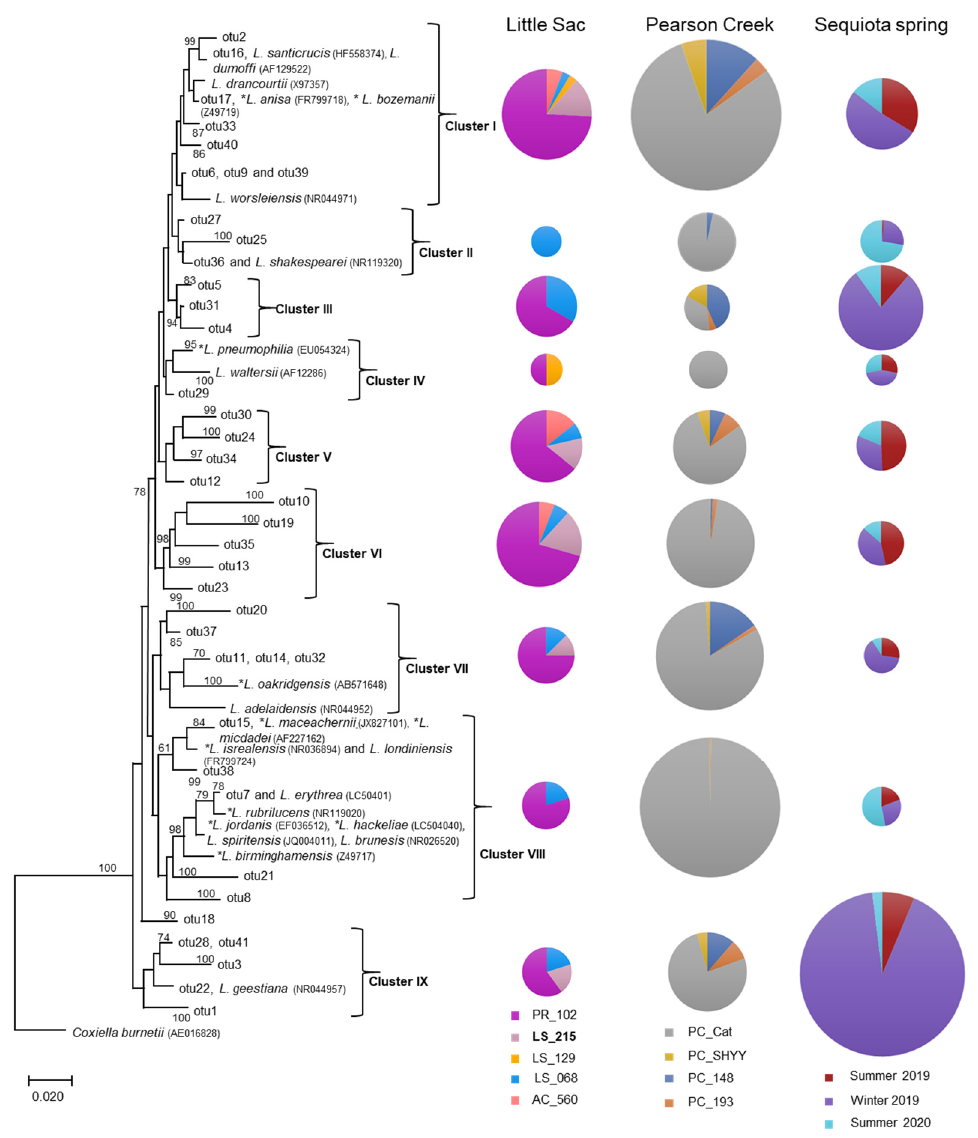
Figure 2. Neighbor-joining phylogenetic tree of partial 16S rRNA gene sequences (370 bp) related to the Legionellaceae family from three impaired watersheds. Only OTUs (operational taxonomic units) containing ≥ 50 sequences were used in this analysis. The DNA sequences of some related pathogenic (*) and non-pathogenic species within the Legionellaceae family were also included in the analysis. The size (diameter) of the pie chart is proportional to the number of sequences within a cluster. The size of a pie chart can only demonstrate the variation in sequences within a given watershed, e.g., a pie chart for the LSW site cannot be compared with a pie chart from Pearson creek. Numbers at the node reflect the bootstrap values.